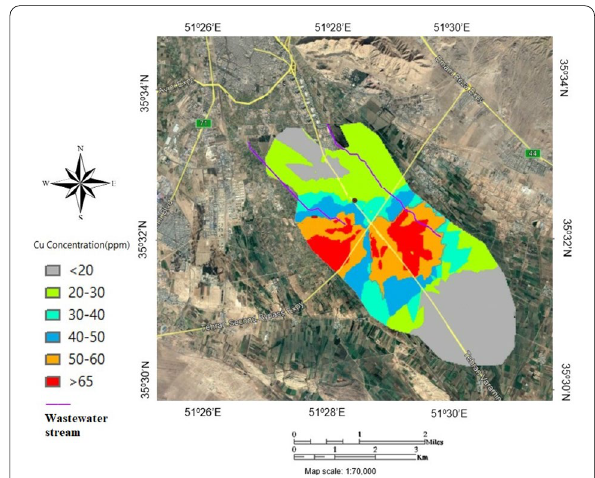
Fig. 3 Distribution heavy metal copper in south Tehran